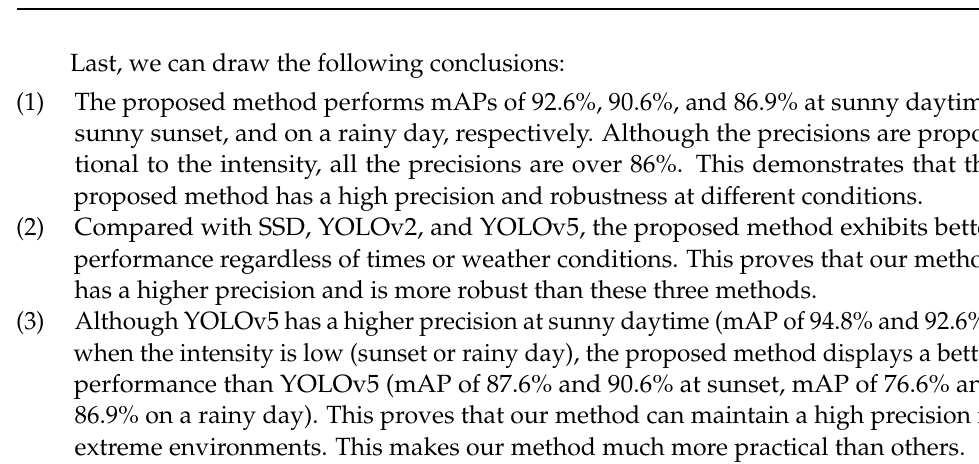
Figure 24. Detection results on rainy day: ( a ) city expressway; ( b ) ordinary urban road. To further evaluate the proposed method, we also conduct the four state-of-the-art methods, namely SSD, YOLOv2, YOLOv3, and YOLOv5, for comparison. The comparison results are shown in Table 6. From the table, we can find that our method has a precision AP of 85.3%, 88.4%, and 82.1%, in small sign, medium sign, and large sign, respectively. Alt- hough the detection accuracy is marginally lower than the test on a sunny day, the pro- posed method still performs better than the four other methods. It can be seen that the proposed method displays great robustness on different weather conditions. Table 6. Results of the comparative experiments on rainy day. Method